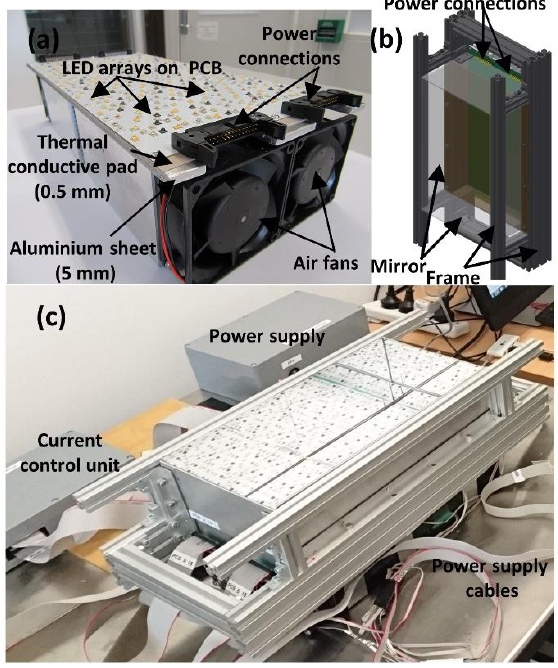
Figure 7. ( a ) Photograph of two aligned PCBs loaded with 532 LEDs of ten colors, mounted on a fan-cooled heatsink to create a larger area unit. ( b ) Schematic illustration of the LED LASS unit arranged on the heatsink with the location of the power connection terminals, the mirrors, and the construction of the aluminum frame. ( c ) The actual LED LASS instrument.